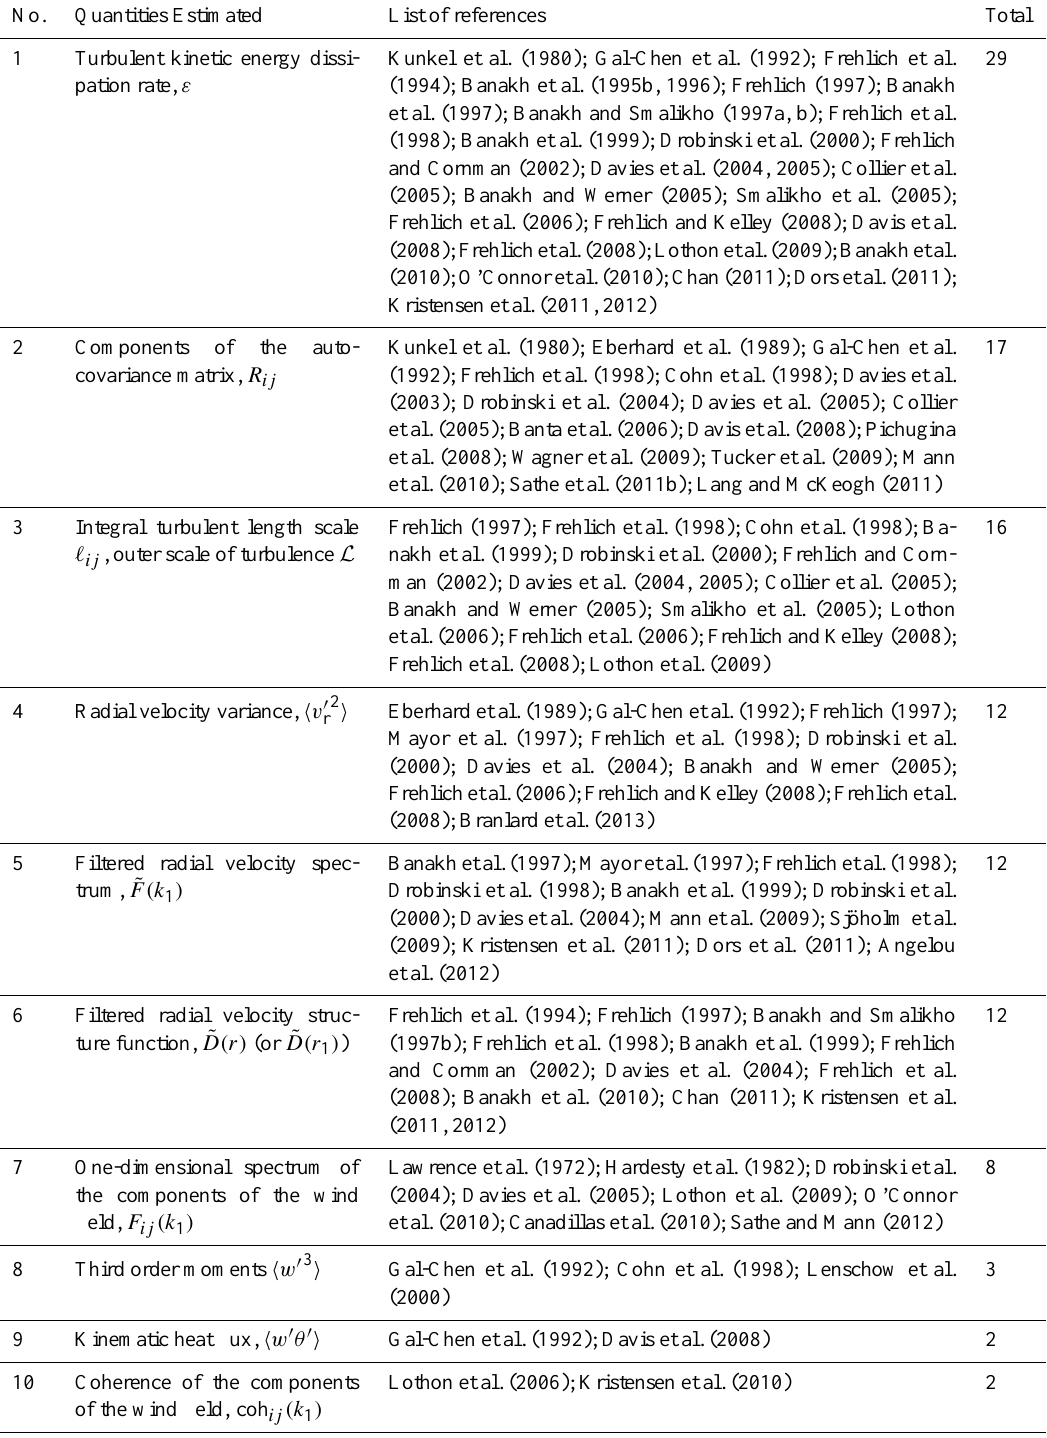
Table 1. Grouping of the past studies according to the estimated turbulence quantity using a